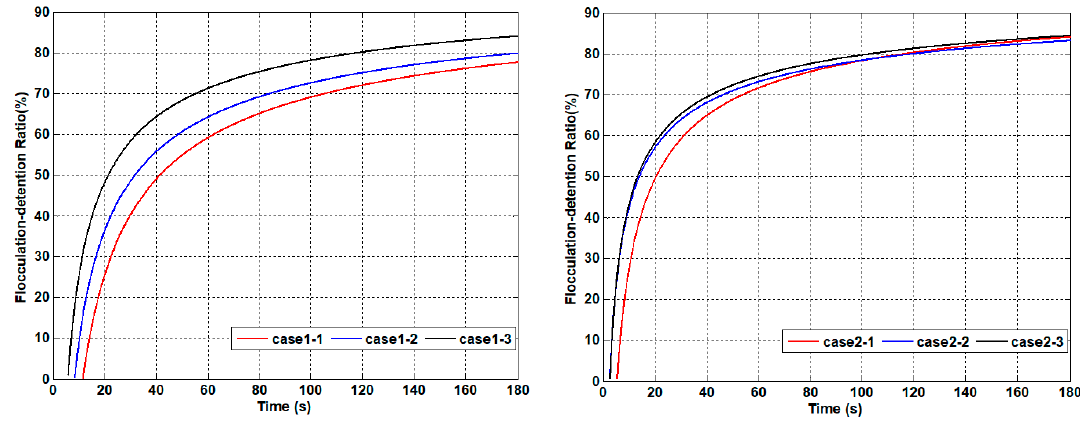
Figure 5. Results of flocculation-detention ratio (%).